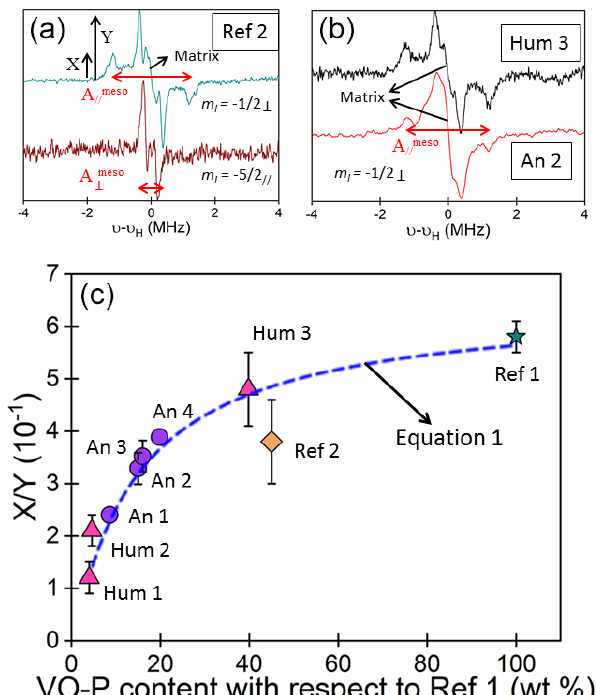
Figure 4. 1 H ENDOR at Q band and at 100K of VO-P com- plexes. (a) Bitumen of Judea (Ref 2), recorded by observing the m I = − 1 / 2 ⊥ (1225.4mT) and − 5 / 2 // hf lines (1197.9mT) of 51 V (see Fig. 2b for the field settings). (b) Hum 3 and An 2 samples recorded at the m I = − 1 / 2 ⊥ hf position (1230.6 and 1252.8mT, respectively). (c) Variation of the ratio X/Y of ENDOR amplitudes versus the weight-normalized VO-P content of samples. The inter- rupted line was calculated from Eq. (1) with b = 15. The horizontal error bars correspond to the size of the data